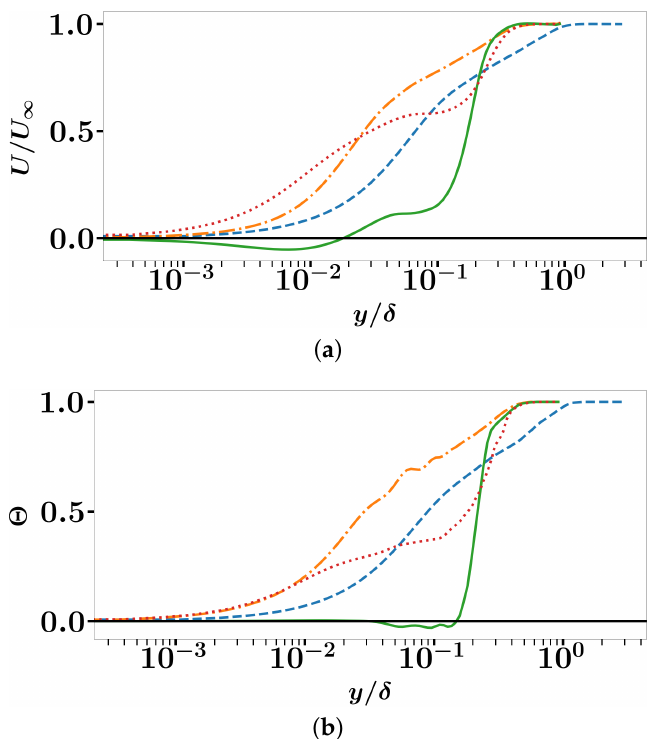
Figure 12. CASE 2: ( a ) mean streamwise velocity in wall units and ( b ) normalized mean temperature (profiles as in the legend of Figure 11a).